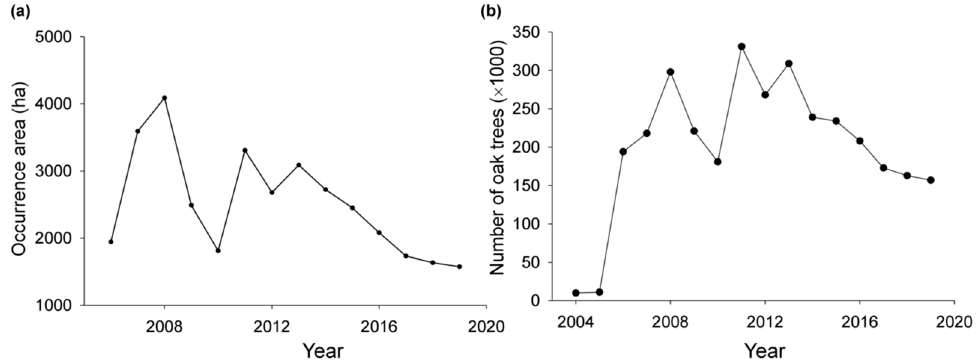
Figure 2. Annual changes in area (ha) damaged ( a ) and the number of dead oak trees ( b ) caused by KOW from 2004 to 2019. The graphs were drawn based on data from Korean Forest Service (www.forest.go.kr (accessed on 1 March 2022)).